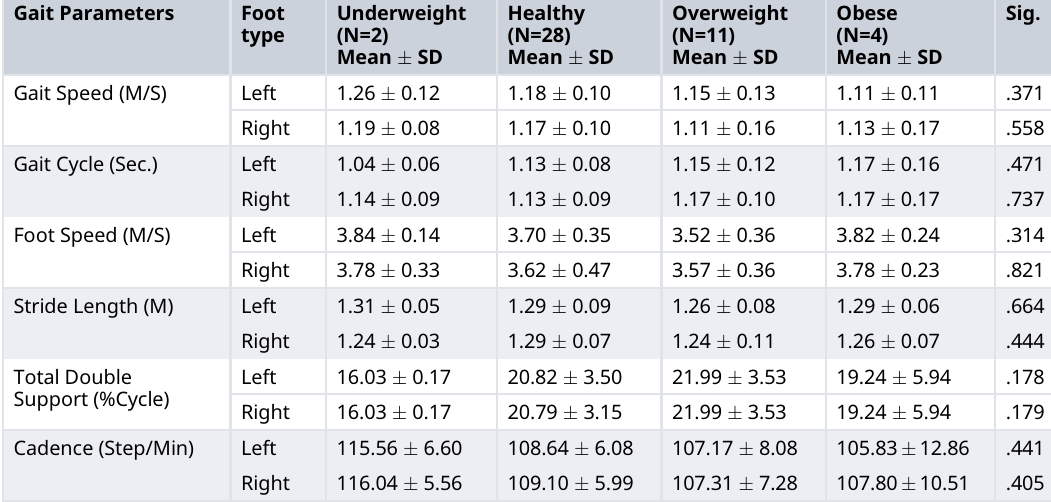
Table 4. A comparative analysis between body mass index (BMI) level.